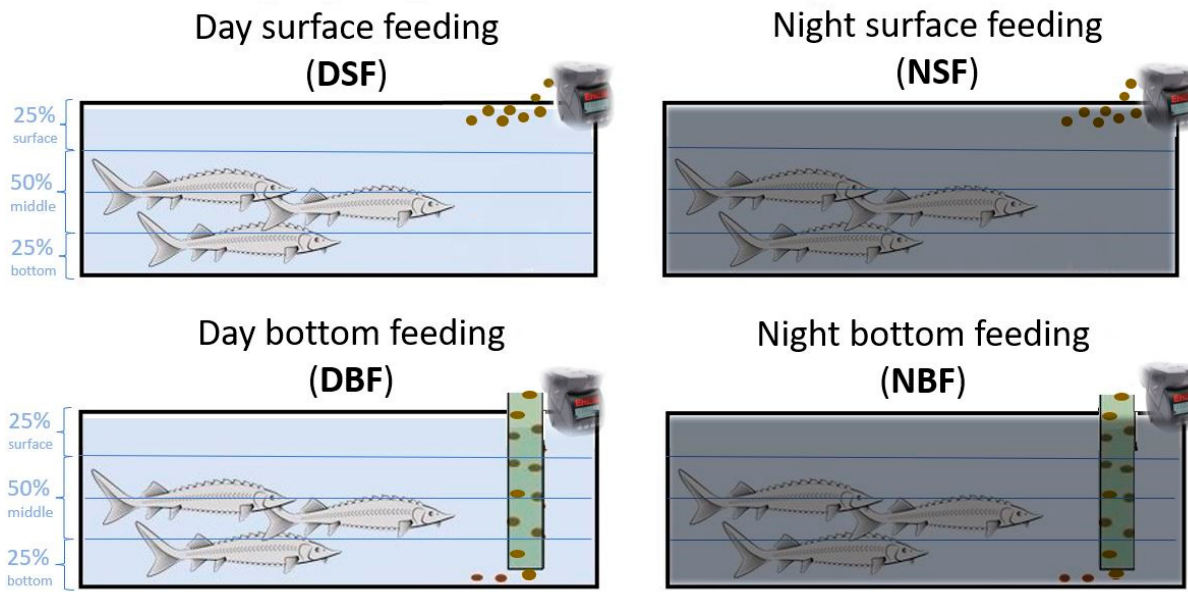
Figure 1. Experimental setup of the two feeding applications (surface and bottom) during day- and night-time hours. Lines show the three video-recorded tank sections: 25% bottom, 50% middle, and 25% surface.